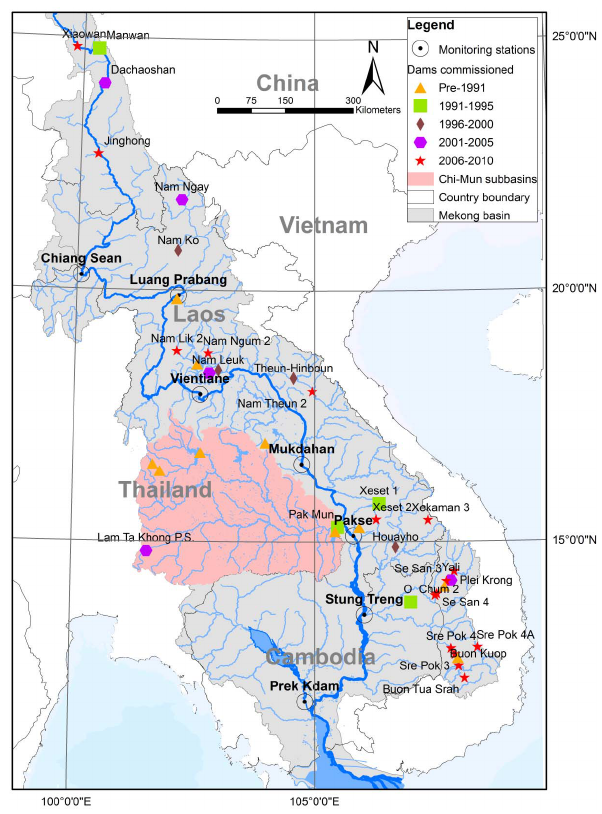
Figure 2. Operating dams and key hydrological monitoring stations in the Mekong Basin up to December 2010. 717